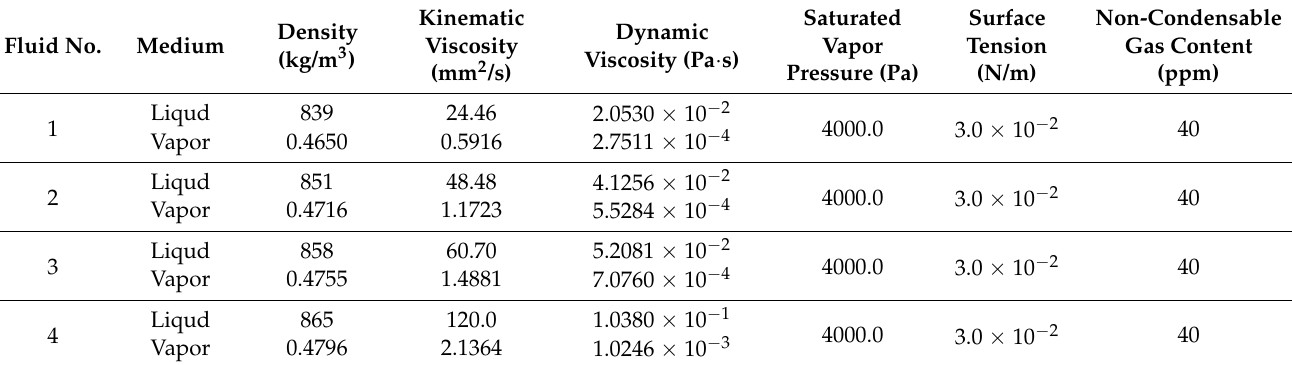
Table 3. Properties of four liquids and their vapors at 20 ◦ C [14,24].